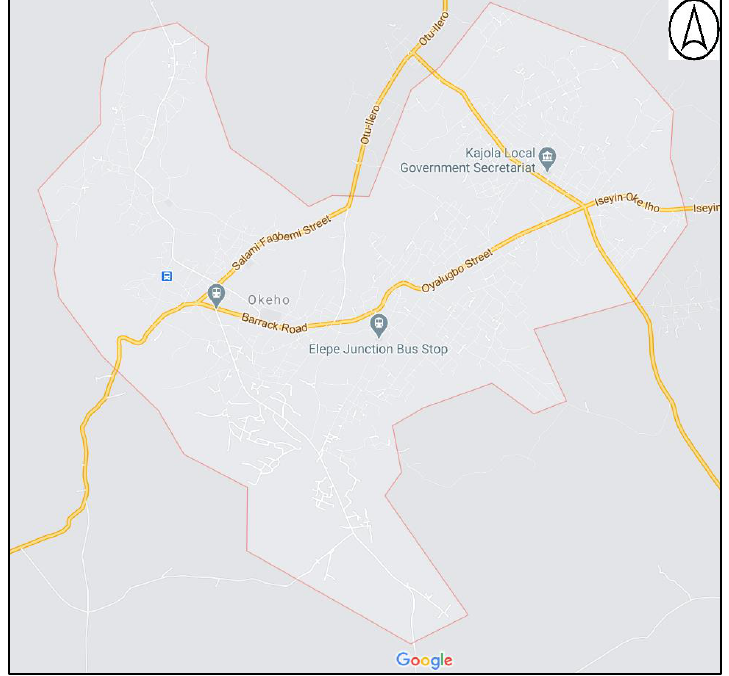
Figure 1. Map showing location of Okeho community in Kajola LGA, Oyo State,